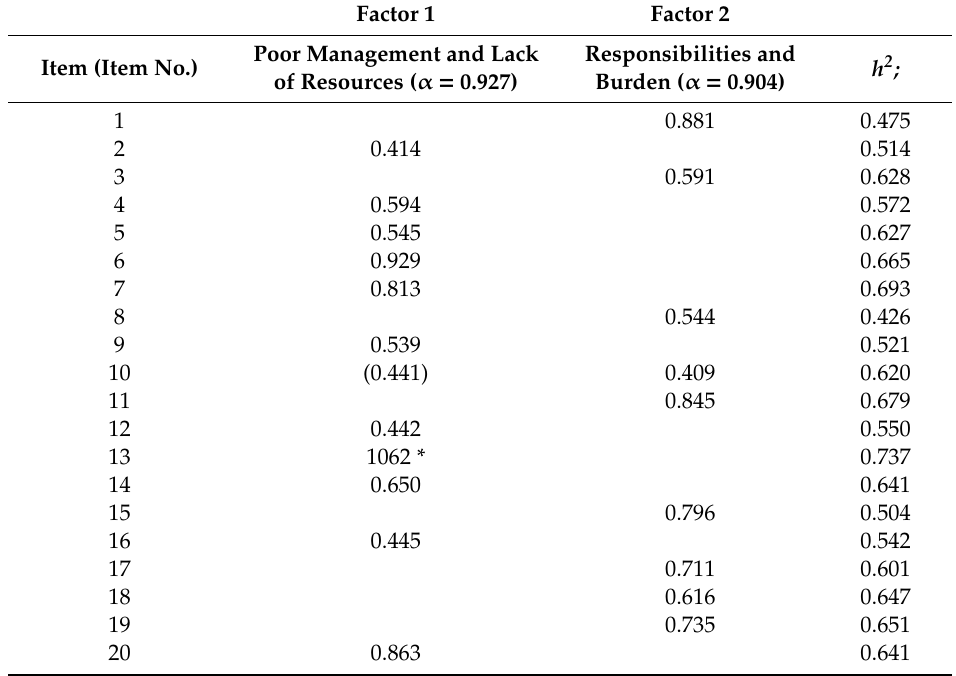
Table 2. Factor Analysis of the PSQ-OR (20 items): two-factor solution using a part of the sample (Database 1; n = 339). Factor 1 Factor 2 Poor Management and Lack Responsibilities and Item (Item No.) h 2 ; of Resources ( α = 0.927) Burden ( α = 0.904) 0.881 0.475